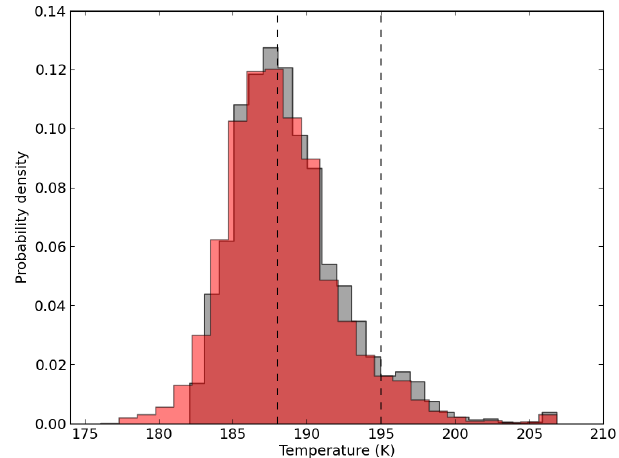
Figure 10. Impact of the mountain wave parameterisation during July at 21km on the probability distributions of temperature over the AP in the perturbed run of the chemistry–climate model. Shown are the 30-year average temperature distributions based on the ex- plicitly resolved temperature T CHEM − CLIM plus the parameterised temperature fluctuations (cid:49)T − (red colouring), and the frequency SSO based solely on T CHEM − CLIM (grey colouring). Regions where the two distributions overlap are coloured a darker shade of red. Both temperature distributions are for the same N48 grid box used for CS1 in Figs. 5, 7, and 8 (i.e. 70 ◦ S, 63.75 ◦ W). In the perturbed run, (cid:49)T SSO is represented by the cooling-phase (cid:49)T − only. The SSO Figure 11. Impact of the mountain wave parameterisation during temperature thresholds of 195 and 188K are marked as dashed ver- July at 21km on PSC surface area density (µm 2 cm − 3 ) over the AP tical lines and are assumed to be representative of the formation of in the chemistry–climate model. The shading indicates the 30-year type Ia and II PSCs, respectively. Both temperature distributions are average difference in surface area density between the perturbation computed from 6-hourly fields. run and the control run (perturbation run minus the control run) for PSC types I and II (a) , type I (b) , and type II (c) . The contours indi- cate the 30-year average PSC surface area density from the control run. Hatching denotes significance at the 95% confidence level us- ing a two-tailed Student t test. Also shown is the coastline of the